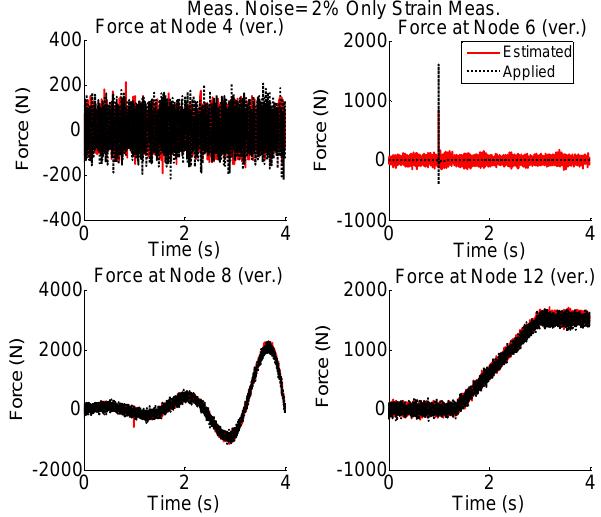
Figure 14. System is simultaneously subjected to four different forces shown with dotted black; Modeling (5%) and measurement error (2% of rms of the random signal) is added and excitation is estimated by AKF using the strain measurements with single acceleration